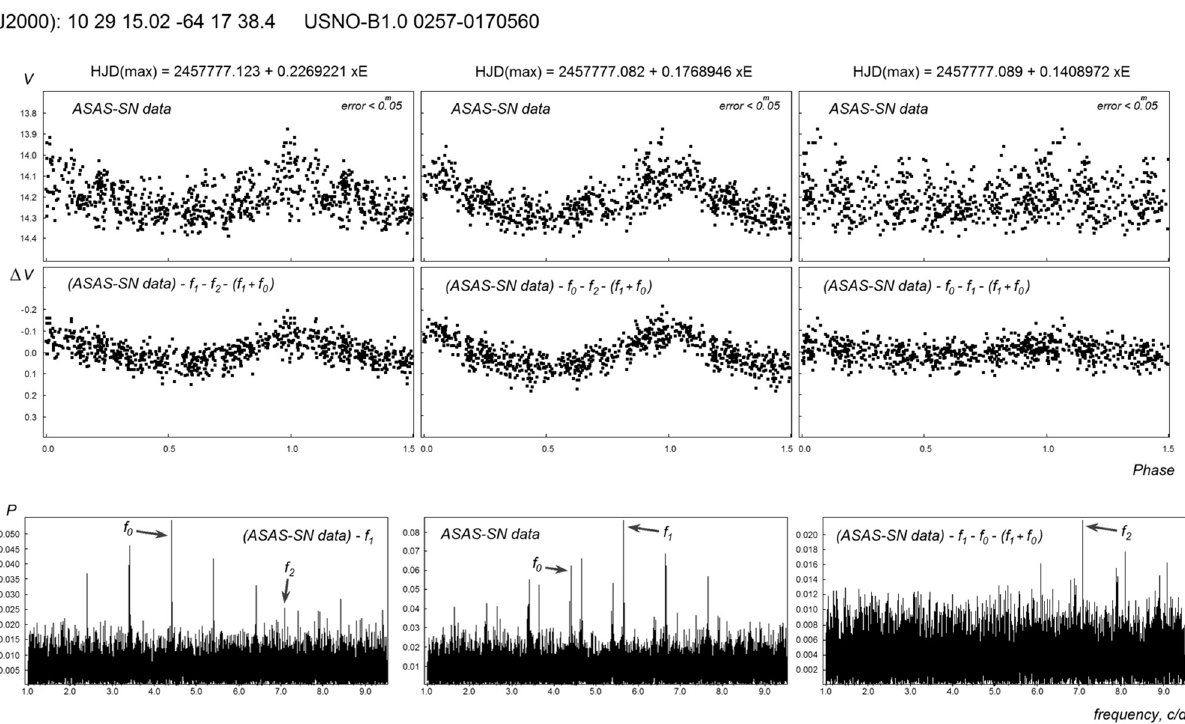
Figure 4: USNO - B1.0 0257 - 0170560 ( No. 4 )